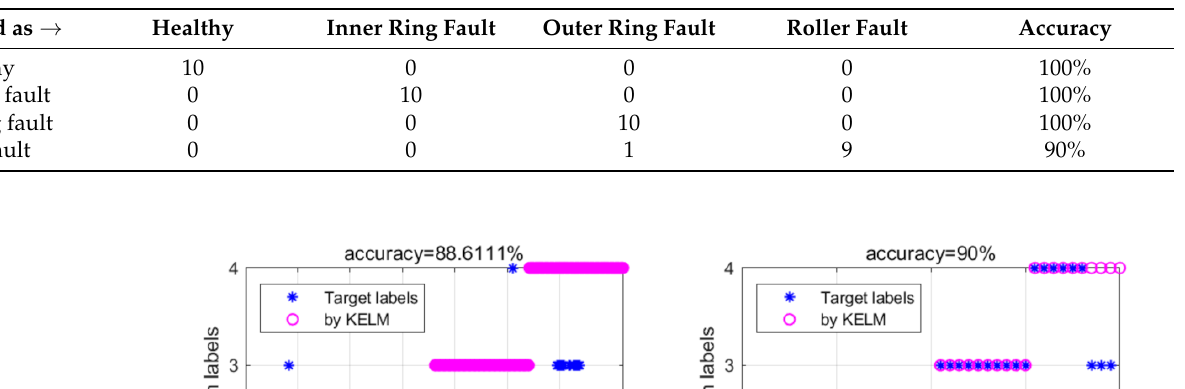
Table 7. Classification results by DE-KELM of each condition.